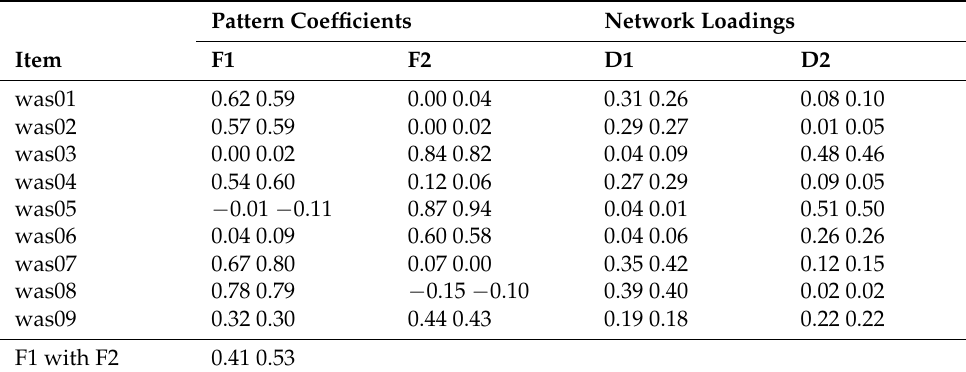
Table 2. Factor loadings (pattern coefficients) from the Exploratory Structural Equation Modeling (ESEM) analyses and structural coefficients (network loadings) from the network analysis. Pattern Coefficients Network